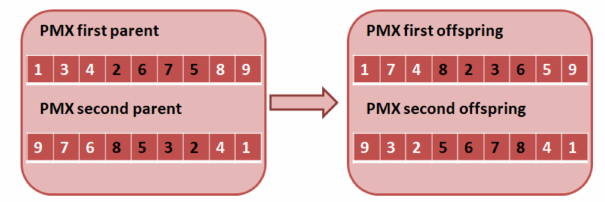
Figure 5. Partially Matched crossover (PMX)